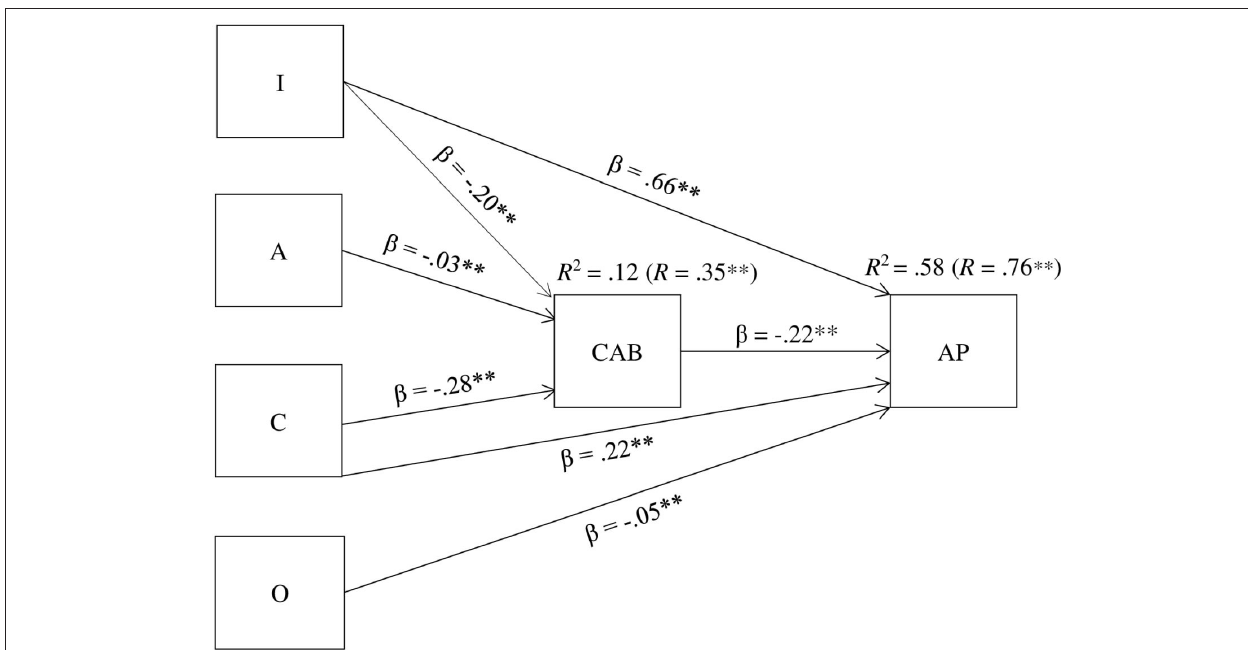
FIGURE 2 | Graphical representation of the meta-analytic path analysis model.